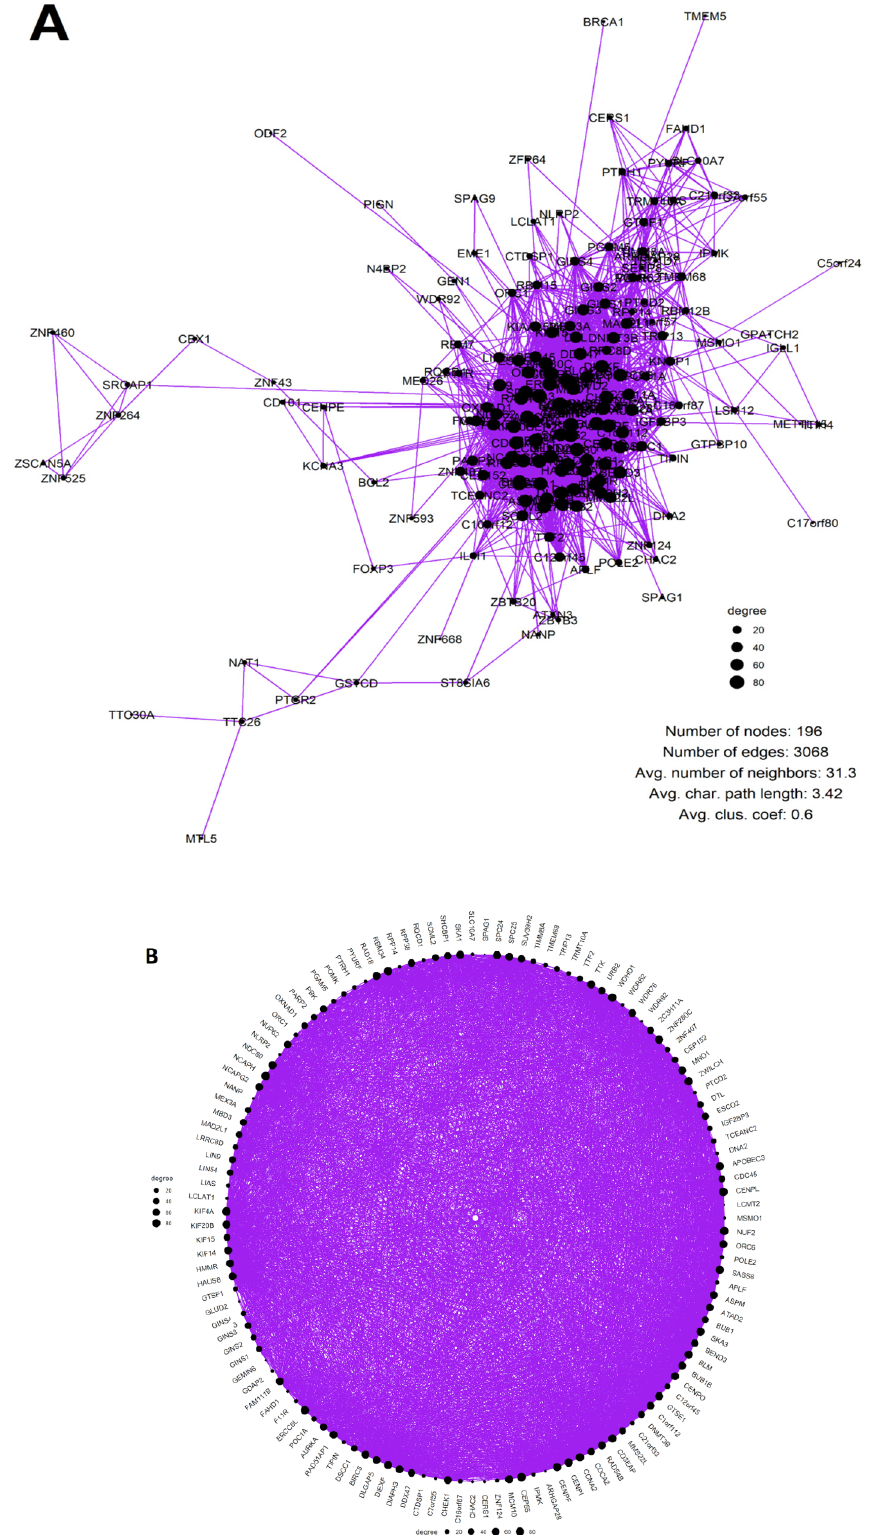
Figure 8. The coexpression networks of GG proteins in the PXD008841 [103] dataset of BRCA proteomes (node size scaled to a degree): ( A ) The full network of GG proteins in 45 BRCA tumour samples ( B ) The most interconnected component (MCL Cluster 1) of the GG protein coexpression network, displayed in a circular layout.